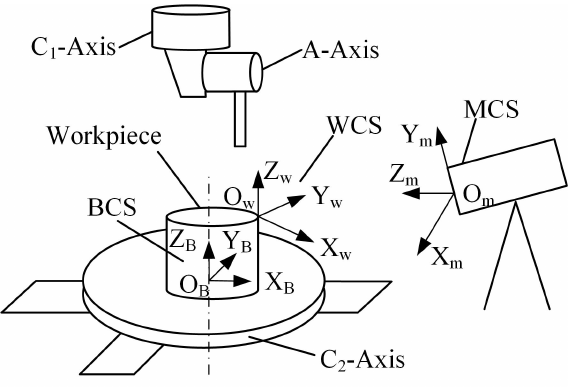
Figure 3. Positional relationship between BCS, MCS, and